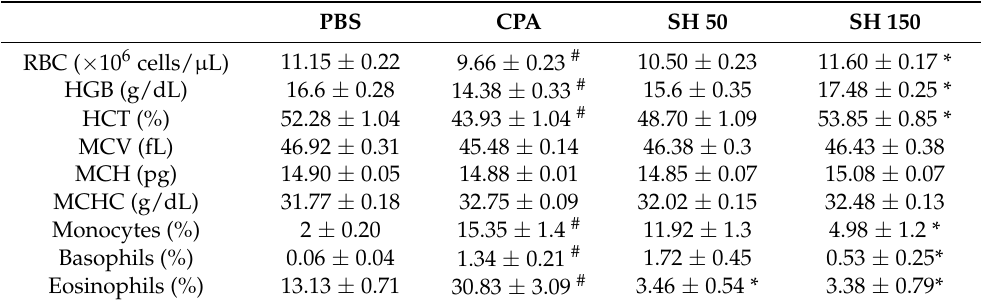
Figure 3. Effects of SH on immune function in a CPA-induced immunosuppressed in vivo model. SH was orally administrated in BALB/c mice for 14 days. CPA was injected on days 14 and 16 to induce immunosuppression. After sacrifice, immune-related parameters were measured. ( a , b ) The body weight of each group was measured, as well as the issue weight and size of ( c , d ) spleen tissues and ( e , f ) thymus tissues. # p < 0.05 vs. naïve mice, * p < 0.05 vs. CPA-injected mice. Results are displayed as mean ± SD of n = 10 per group. Table 2. Blood parameters in CPA-induced immunosuppressed